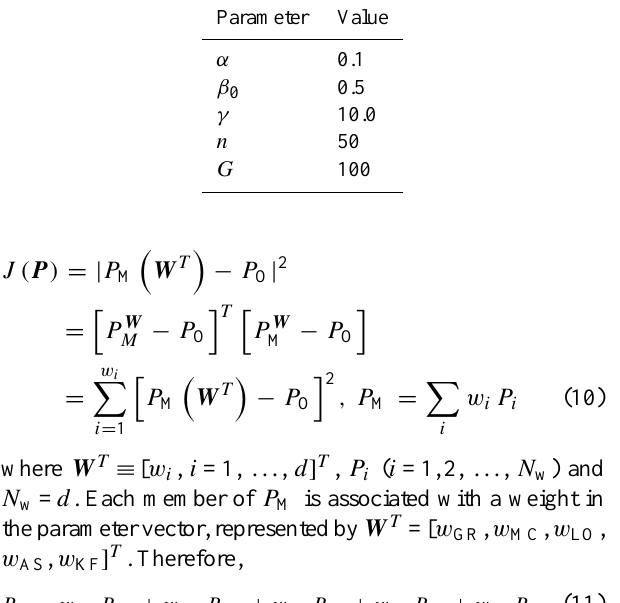
Fig. 2. Areas used to calculate the statistical scores. The numbers represent corresponding areas indicated in the text.